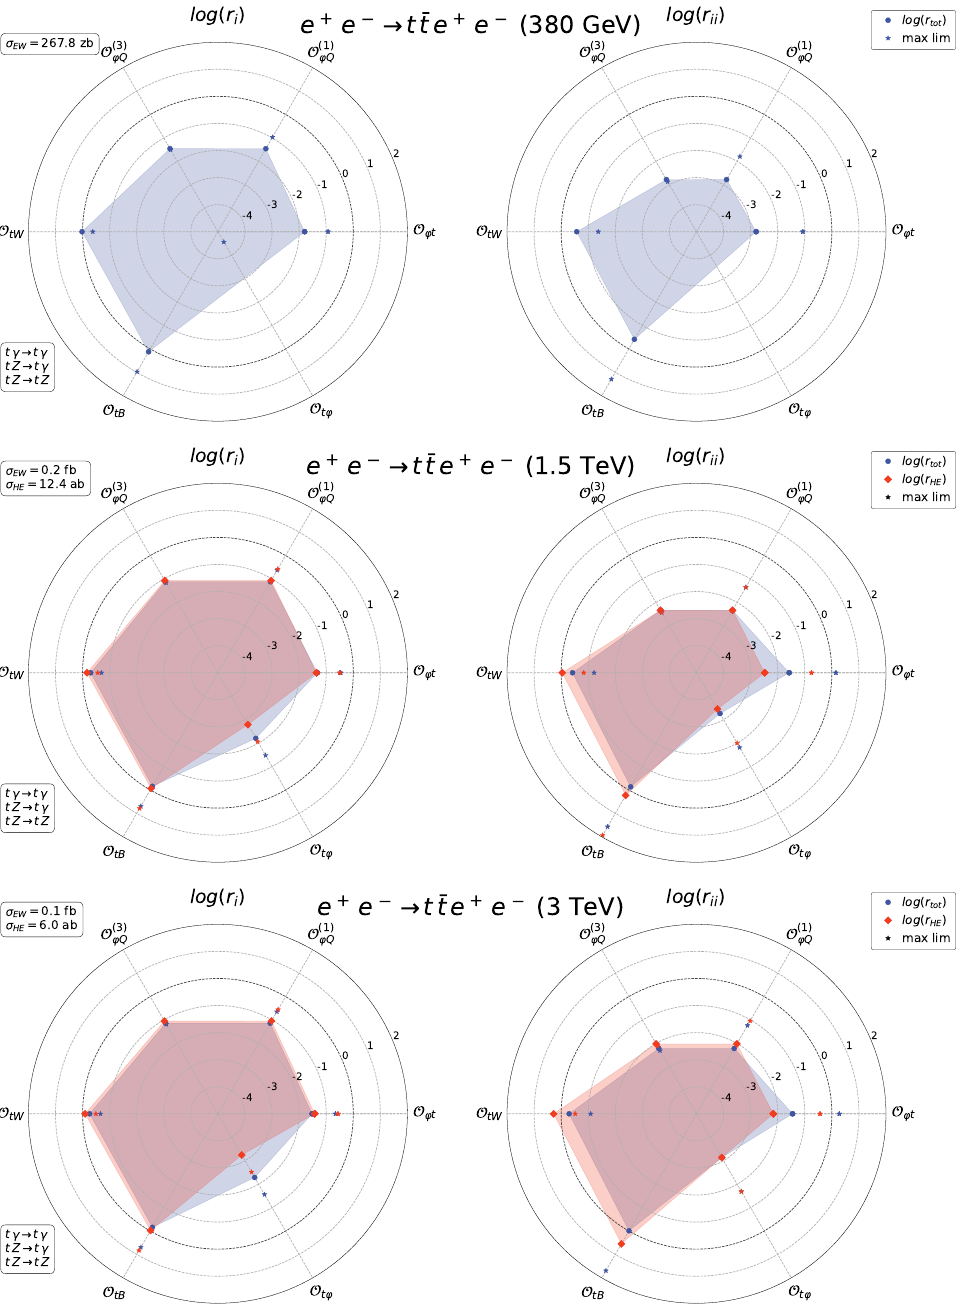
(cid:22) t e + e Figure 32. Radar plot for the e + e (cid:0) ! t (cid:0) process at collider centre of mass energies of 380 ( upper ), 1500 ( middle ) and 3000 GeV ( lower ), see (cid:12)gure. 7 and section 4.1.2 of the main text for a detailed description.